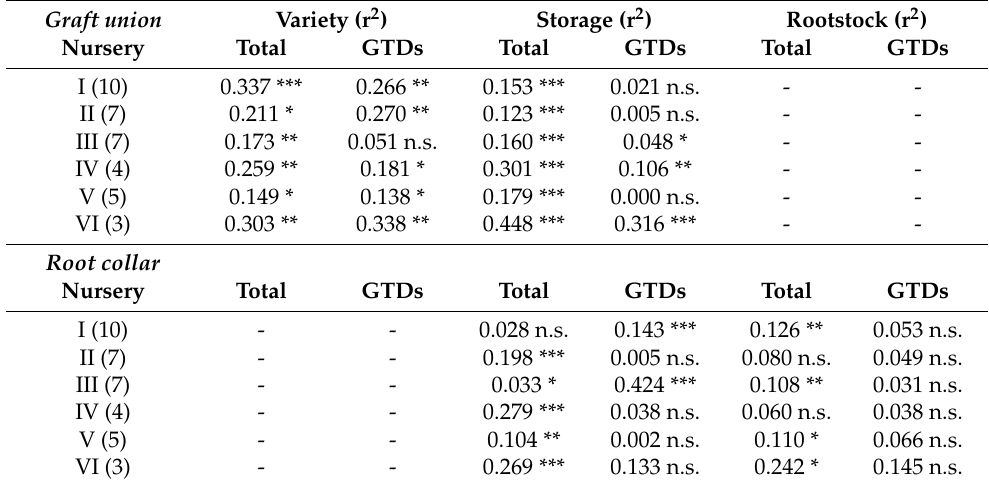
Table 5. Contribution of the investigated factors to the composition of the entire fungal community (total) and of only GTDs in each nursery. The number in parentheses indicates the number of varieties produced by each nursery. Annotation next to the numbers indicates significance level: *** < 0.001,